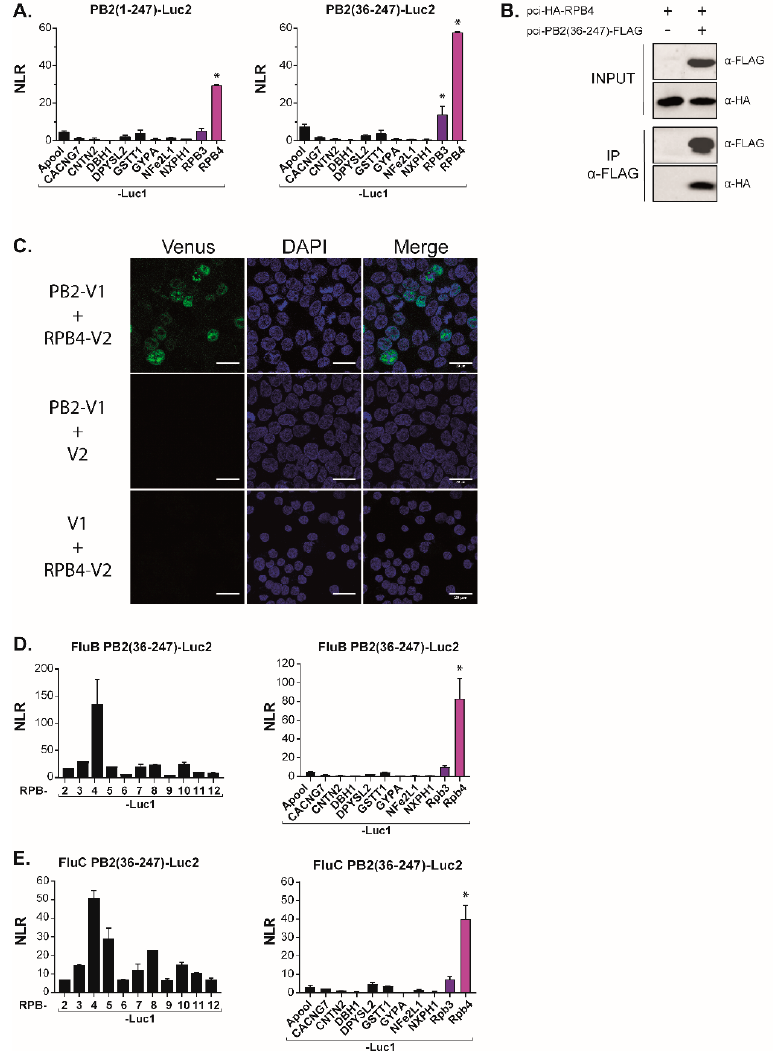
Figure 4. PB2-N domain interacts with the Pol II subunit RPB4. ( A ) Split-luciferase assays between PB2-N forms (Luc2-PB2(1 − 247) and Luc2-PB2(36 − 247) and Luc1-tagged irrelevant proteins(Apool for MICOS complex subunit MIC27, UniProtKB ID Q6UXV4; CACNG7 for Voltage-dependent calcium channel gamma-7 subunit, P62955; CNTN2 for Contactin-2, Q02246; DBH1 for dopamine beta-hydroxylase, P09172; DPYSL2 for dihydropyrimidinase-related protein 2, Q16555; GSTT1 for glutathione S-transferase theta-1, P30711; GYPA for glycophorin-A, P02724; NFE2L1 for endoplasmic reticulum membrane sensor NFE2L1, Q14494 and NXPH1 for Neurexophilin-1 for P58417). Data are mean ± s.d. n = two technical replicates. ( B ) Coimmunoprecipitation assay. Plasmids encoding HA-RPB4 and PB2(36 − 247)-FLAG were transfected in HEK 293T cells. Twenty-four hours post-transfection, cells were lysed, PB2(36 − 247)-FLAG was immunoprecipitated and RPB4 was revealed by Western Blotting. ( C ) Split-Venus complementation assay between PB2 and RPB4. HEK 293T cells were co-transfected with expression plasmids encoding PB2-Venus1 (PB2-V1), RPB4-Venus 2 (RPB4-V2) and/or with plasmids encoding Venus1 (V1) and Venus2 (V2) moieties. Cells were fixed 24 h later, nuclei were marked with DAPI and fluorescence emitted by reconstituted Venus was measured by confocal microscopy. Bars = 20 µ m. ( D , E ) The interaction between PB2(36 − 247) and RPB4 is conserved in influenza types B and C. Plasmids encoding luc2-tagged forms of PB2(36 − 247) from influenza B ( D ) or influenza C ( E ) viruses were co-expressed with Luc1-tagged Pol II subunits in HEK 293T cells. Twenty-four hours post transfection, cells were lysed and luminescence was measured. NLR values were calculated as described in Figure 1. Data are means ± s.d. n = two technical replicates representative of two independent assays. * indicates outliers with a p <